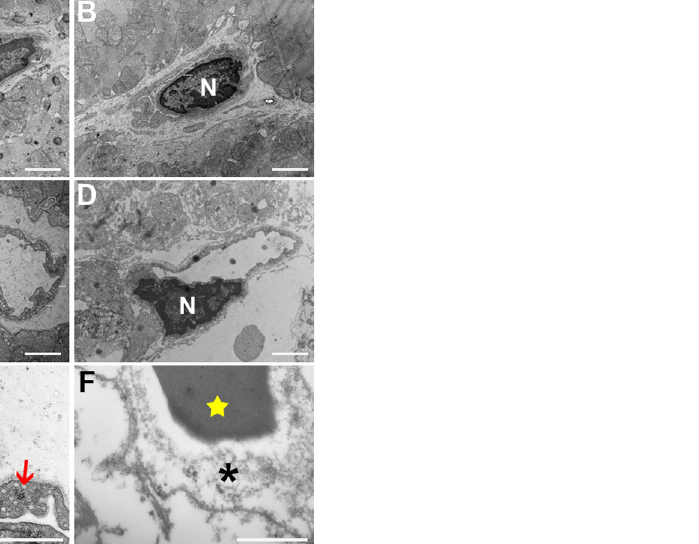
Fig 4. Ultrastructural images. Magnification A-D 10500x. A Capillary in the control tissue. B Capillary from infarct zone of the 30 – 0 group. In both A and B an intact continuous vessel wall can be seen. C Image depicts the 90 – 0 group and shows activated endothelium with abundant presence of caveolae and vesicles. Cytoplasm shows great variety in thickness, with multiple protrusions (white triangles). D Capillary from group 30 – 60 which shows severely damaged vessel wall with disruption of the basal membrane. E and F show detailed images with numerous caveolae (red arrows) and destruction of the vessel wall (asterisk). Also an erythrocyte can be seen (star). Nucleus indicated with the letter N. White bars represent 2 micrometer. Magnification E-F